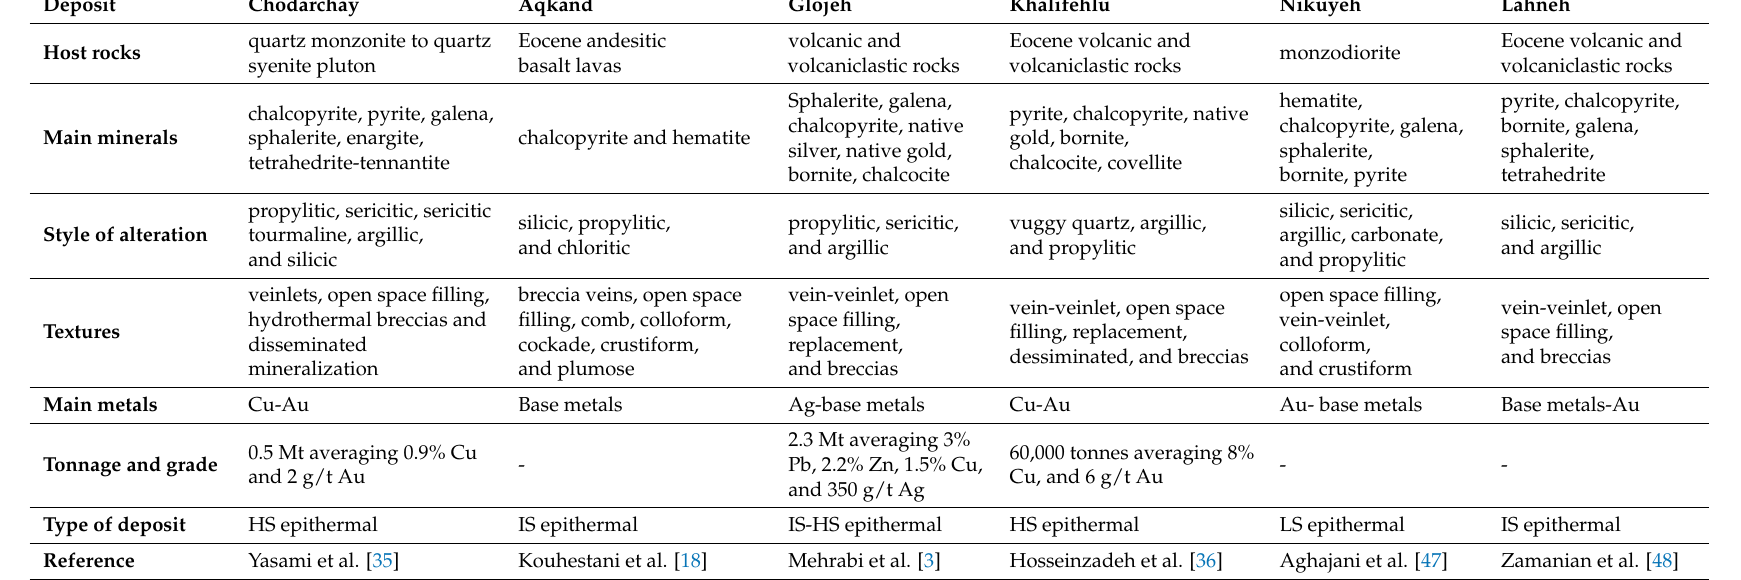
Table 1. The main features of epithermal deposits in the Tarom-Hashjin Metallogenic Province a